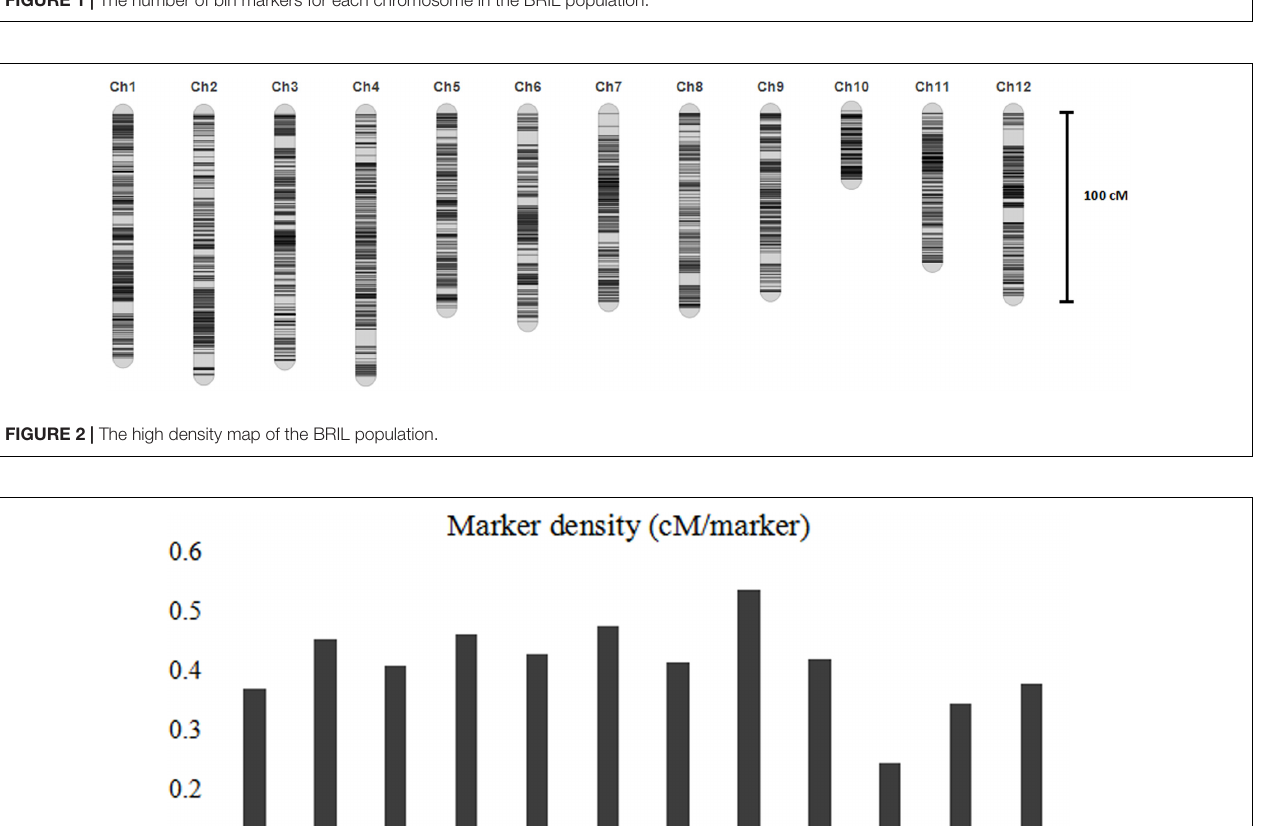
FIGURE 1 | The number of bin markers for each chromosome in the BRIL population.